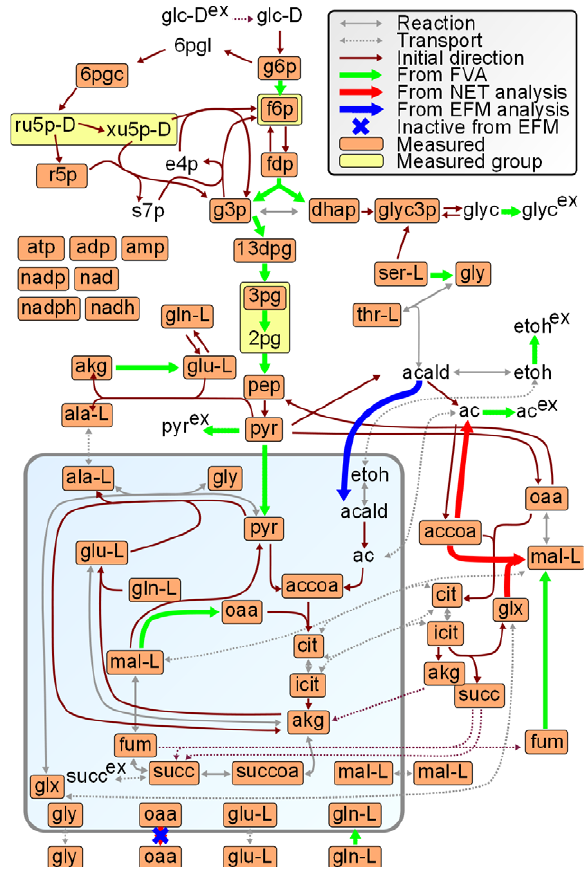
Figure 2. Overview of the main reactions in the metabolic model of S.cerevisiae . The shaded area indicates the mitochondrion. The colors of the directed arrows indicate from which information a constraint was added. The blue cross indicates the oxaloacetate transported that is predicted to be inactive after analyzing the thermodynamically feasible EFMs. For a list of metabolite names see Dataset S2.